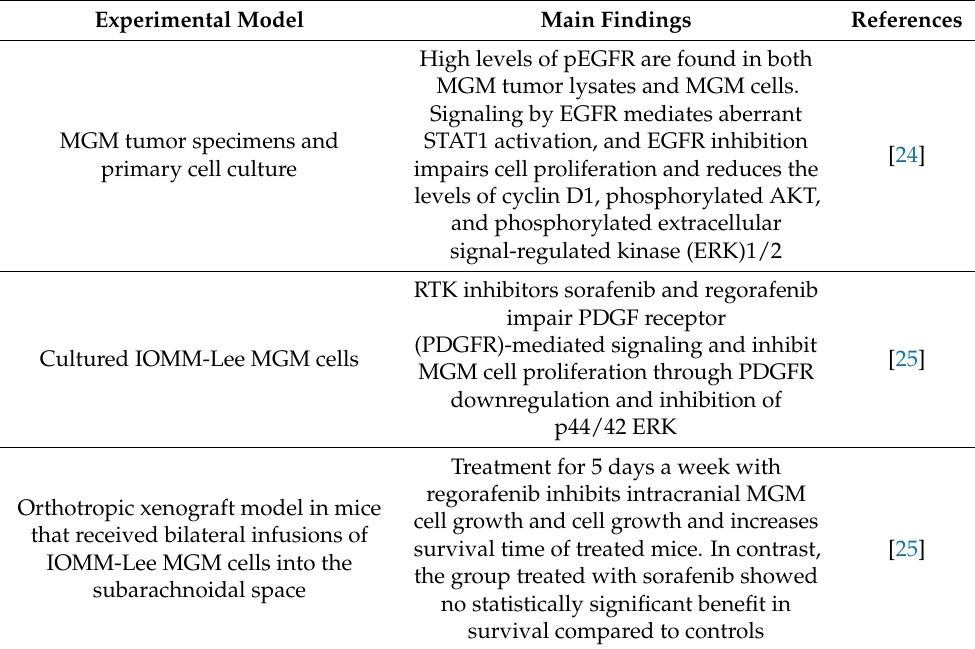
Table 1. Summary of selected experimental and clinical studies presenting evidence for RTKs as therapeutic targets in